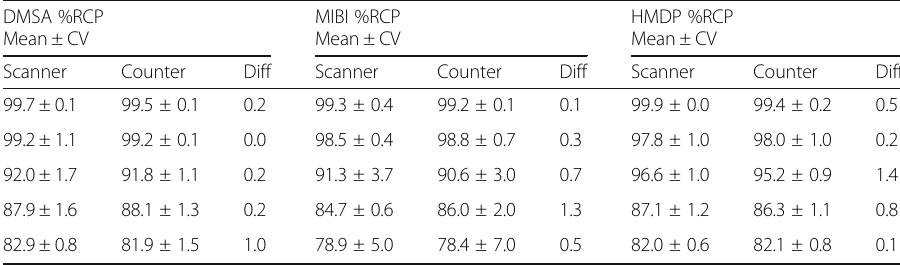
Table 1 Accuracy of the proposed method for the 3 compounds